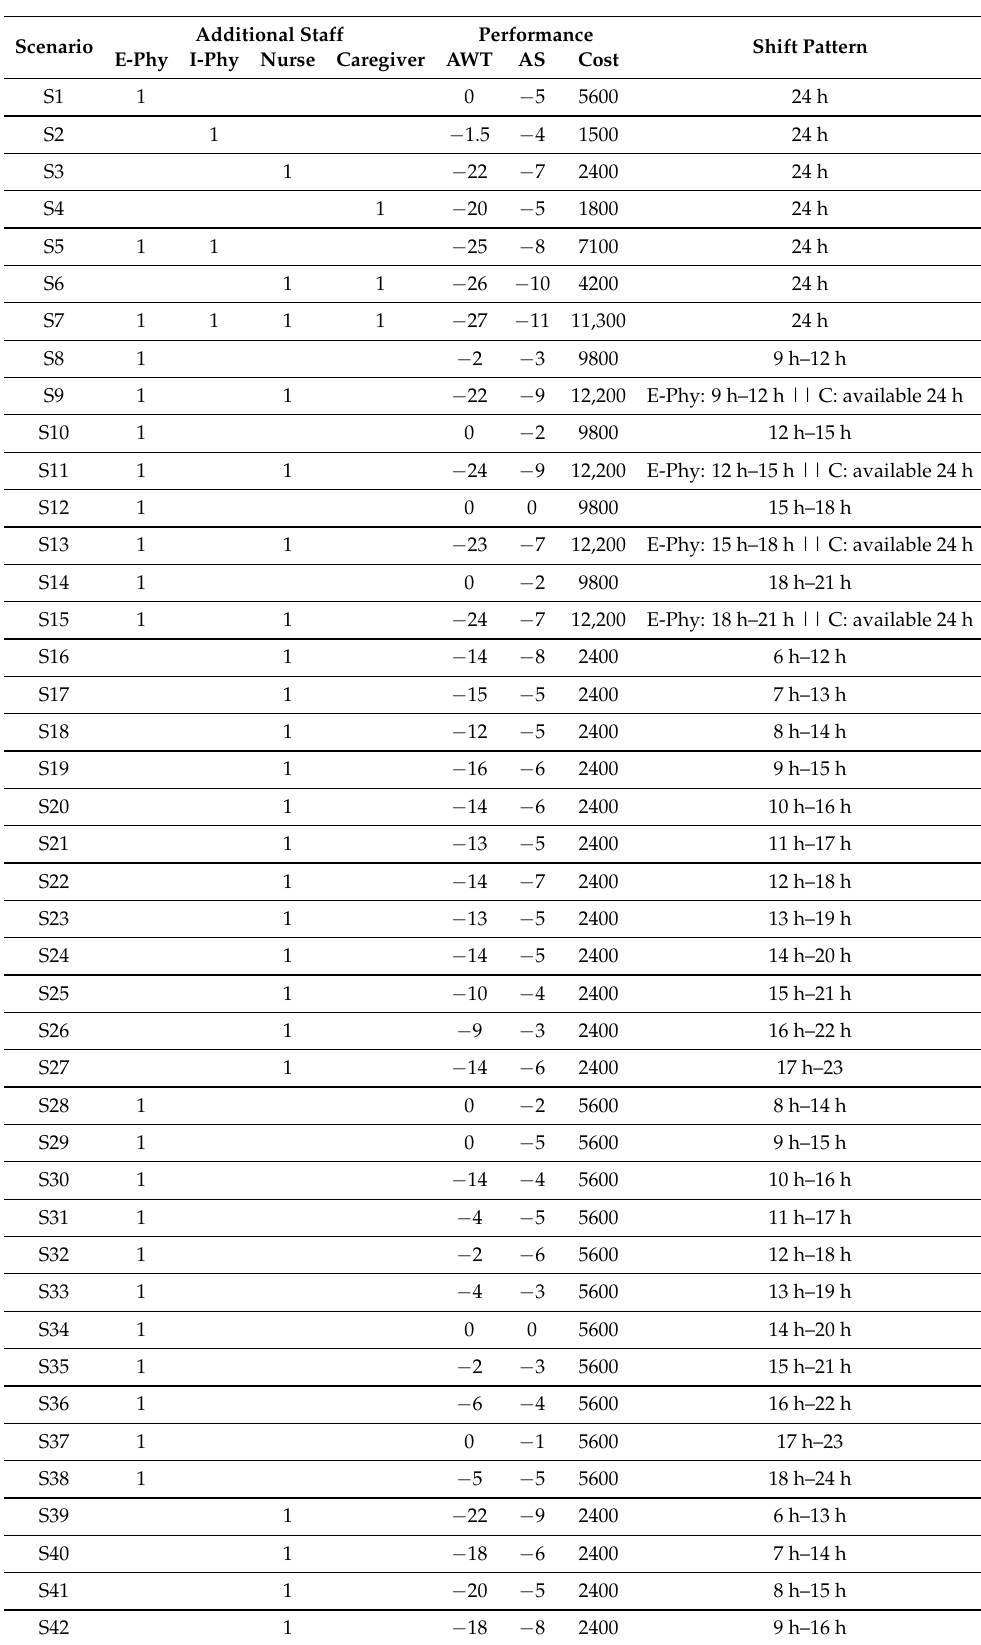
Table A1. Proposed scenarios of Category 1 and their decision matrices (short